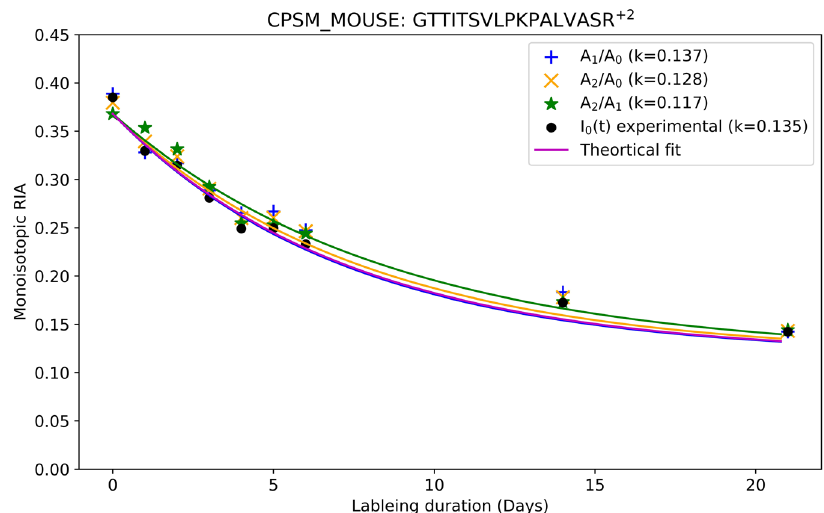
Fig. 2 An approach using two mass isotopomers accurately reproduces the monoisotopic RIA from the complete isotope pro fi les. The time series of monoisotopic RIAs (y-axis) is shown along the labeling duration (x-axis). The turnover rates, which were computed by using the reconstruction of the RIAs by each one of the three ratios, A 1 (t)/A 0 (t) (blue pluses), A 2 (t)/A 0 (t) (yellow crosses), and A 2 (t)/A 1 (t) (green stars), agreed to up to 14% with the turnover rate (0.135 day − 1 ) calculated using the complete isotope pro fi le. Solid lines show the fi ts from the corresponding (based on the color of the data points) label enrichment determination technique. CPSM_MOUSE – mouse protein carbamoyl-phosphate synthase (ammonia),